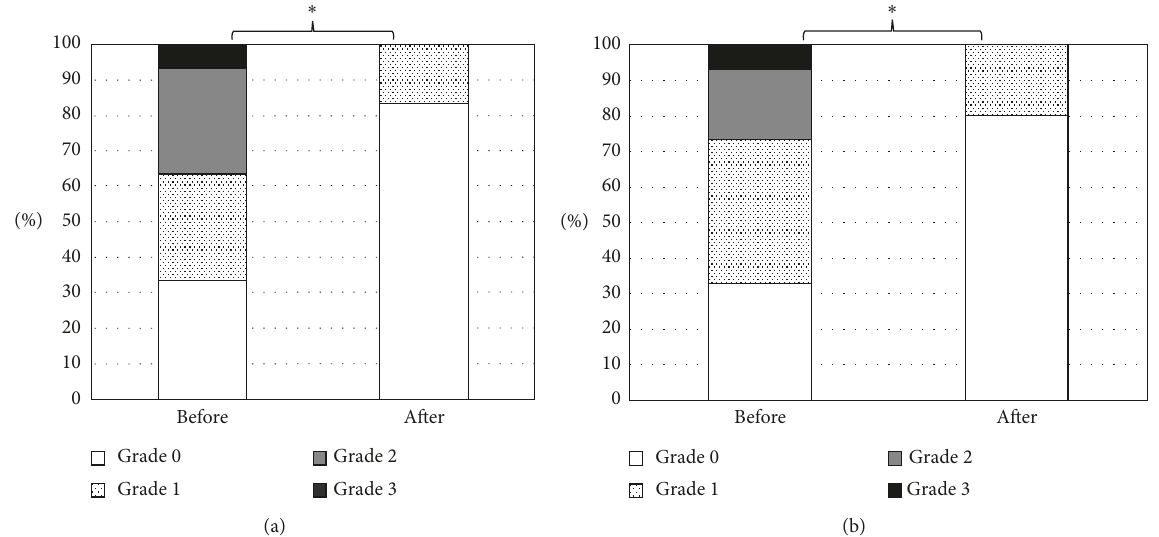
Figure 1: Changes in corneal epithelial damage. Changes in distribution of grades of corneal epithelial damage in area (a) and density (b) before and after Trabectome surgery. ∗ P < 0 . 001, contingency table analysis.